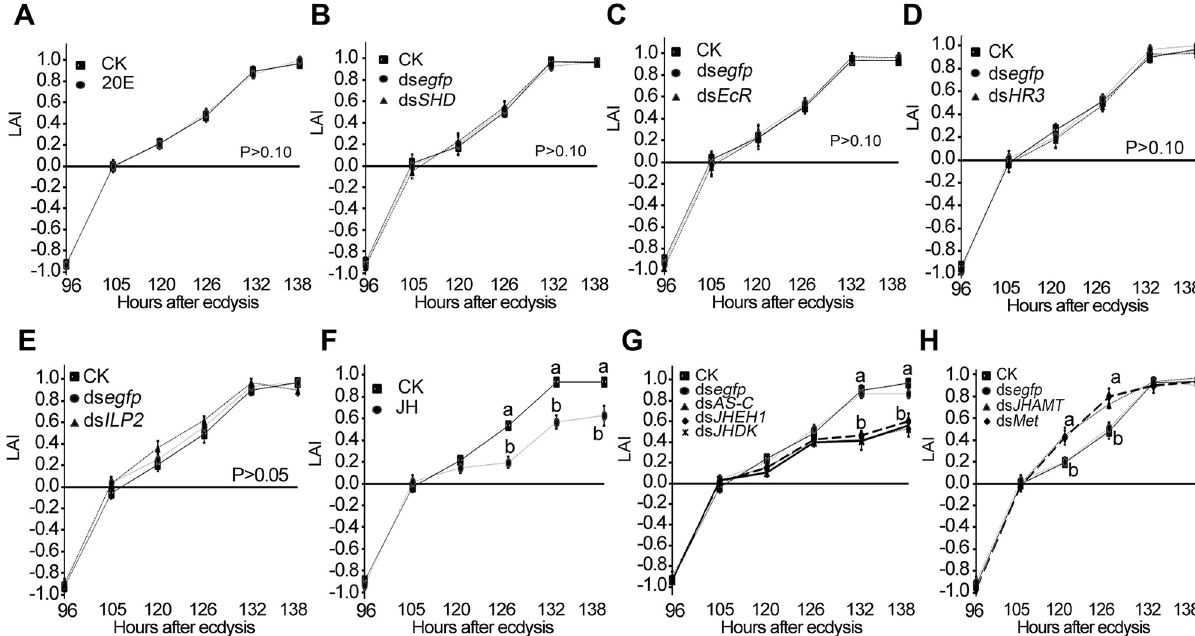
Fig 2. Involvement of JH signal in control of phototaxis switch. 20E pulse was prematurely generated by feeding of 20E (A); 20E signal was reduced by knockdown of an ecdysteroidogenesis gene SHD (B), the 20E receptor gene EcR (C), and a signaling gene HR3 (D). ILP signal was inhibited by silencing of ILP2 (E). JH titer was increased by feeding of JH (F), knockdown of AS-C , JHEH1 and JHDK (G); JH pathway was repressed by silencing of JHAMT and Met (H). Larvae having ingested PBS (CK) and ds egfp were set as blank and negative controls. Light avoidance indexes (LAI) were calculated at each testing time point from 72 to 138 hours after ecdysis. Significant differences between blank control (CK) and treatments at each tested time point are indicated by different letters (P <